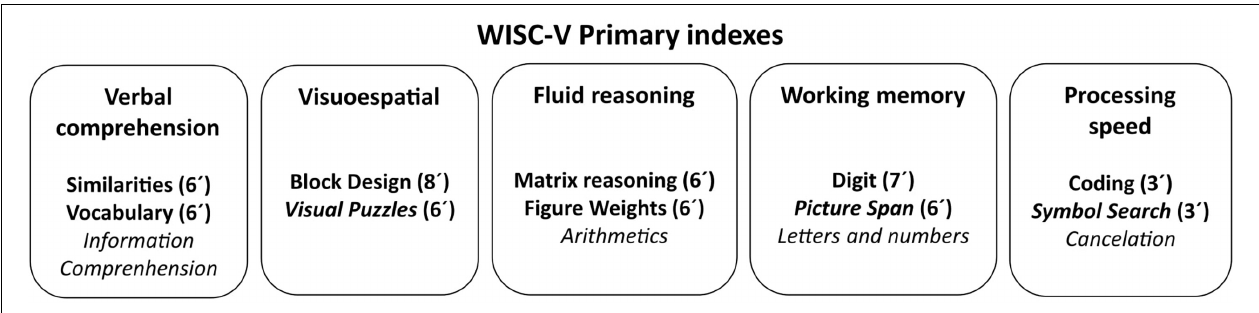
FIGURE 1 | WISC-V Primary indexes and their subtests. All WISC-V subtests are included in the figure. The main subtests needed for calculating the indexes and the estimated administration time (in minutes) for each are displayed in bold.